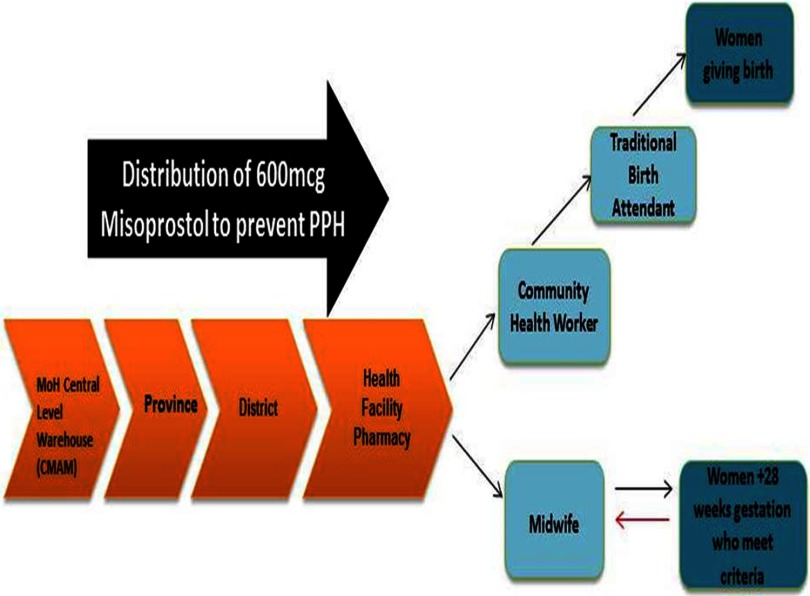
The Innovation: Misoprostol Distribution Chain